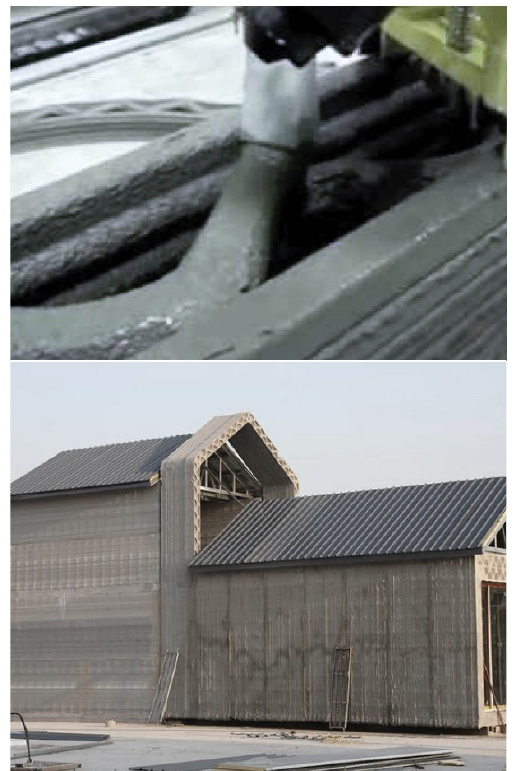
Figure 3. (Top) Contour Crafting, with layers of approximately 5 cm. (Bottom) House printed and assembled by